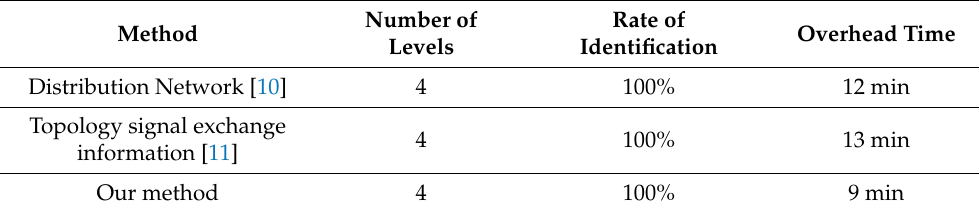
Table 6. Comparison of identification results.